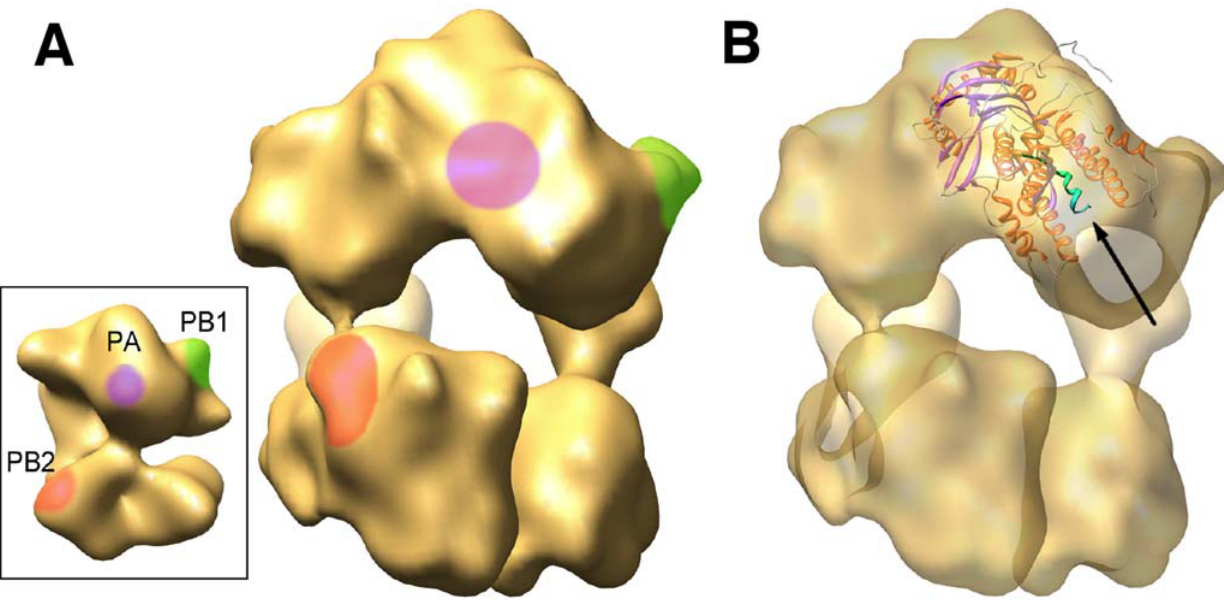
Figure 3. Docking the atomic structure of PA-PB1 complex into the RNP structure. (A) The insert shows the three-dimensional model for the virus polymerase complex present in the RNP as reported by Area et al. [16]. The handedness of the structure has been reversed as compared to the one published, as indicated by the docking of the atomic structure of the NP (see Supporting online material). The location of specific domains in the PB1 (green), PB2 (red) and PA (violet) subunits are indicated. A front-view of the polymerase present in the RNP cryo-EM structure is presented, with the locations of the polymerase domains as inferred from the negative-stained model. (B) The same front-view of the polymerase is presented with the docking of the PA(C)-PB1(N) dimer. The N-terminal PB1 peptide is indicated with an arrow and highlighted in